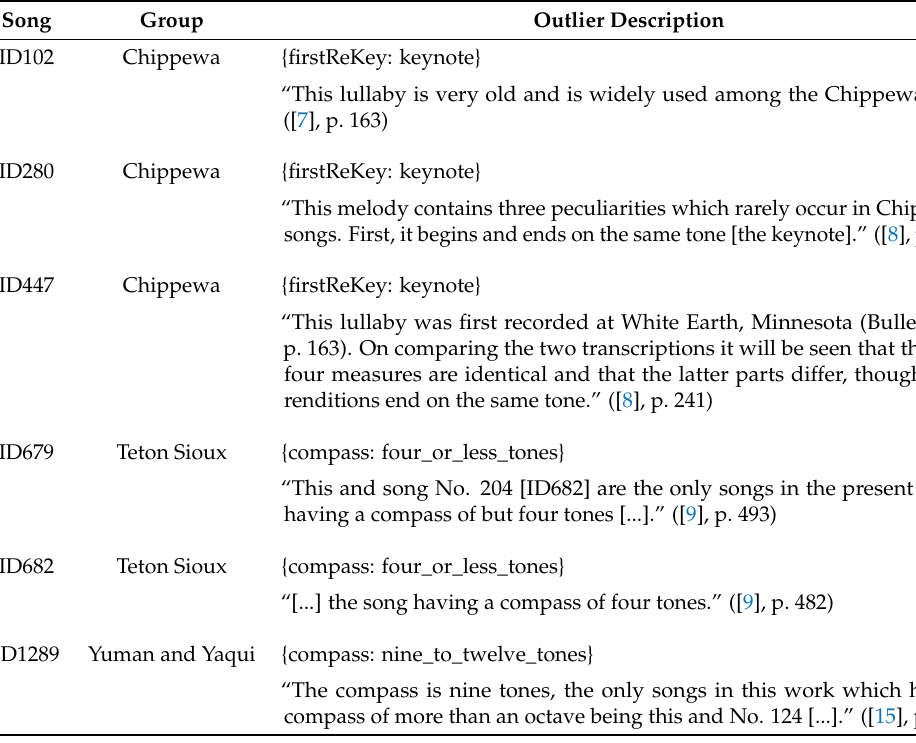
Table 7. Outliers in the Densmore collection which invite further inspection considering metadata or contextual information (for details see